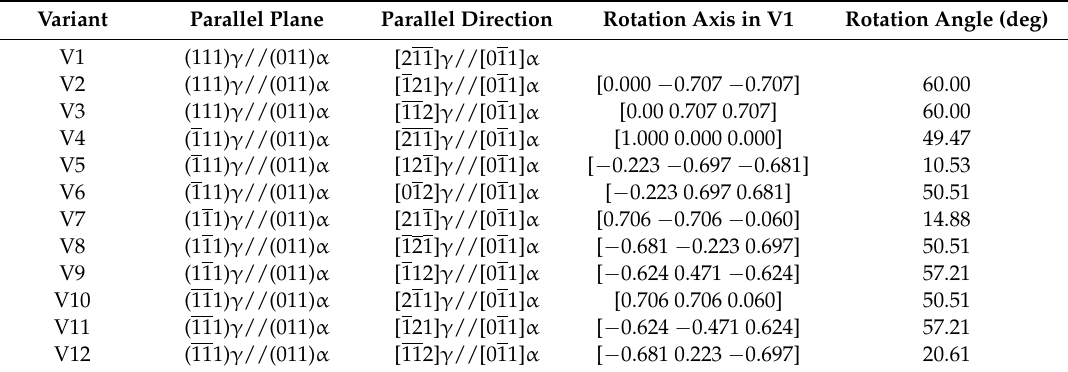
Table 4. The 12 variants for the N ‐ W orientation relationship